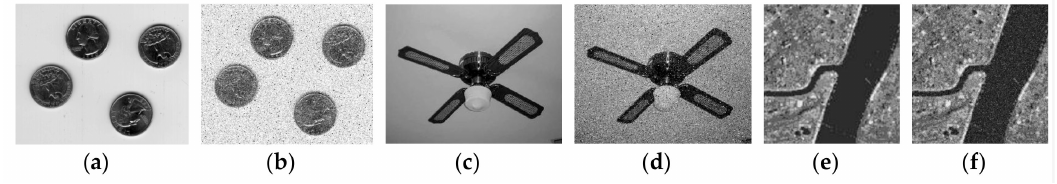
Figure 5. ( a ) Noise-free natural image 1; ( b ) natural image 1 polluted by synthetic noise; ( c ) noise-free natural image 2; ( d ) natural image 2 polluted by synthetic noise; ( e ) noise-free remote sensing image 1; ( f ) remote sensing image 1 polluted by synthetic